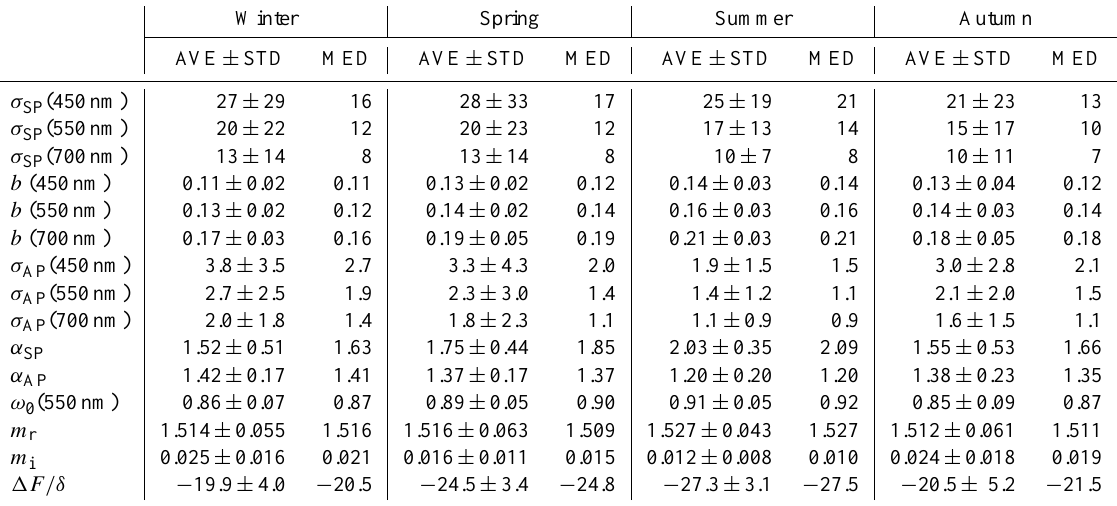
Table 2. Statistical summary of hourly-averaged aerosol optics data in winter (December–February), spring (March–May), summer (June–August), and autumn (September–November). Units as in Table 1. Winter Spring Summer